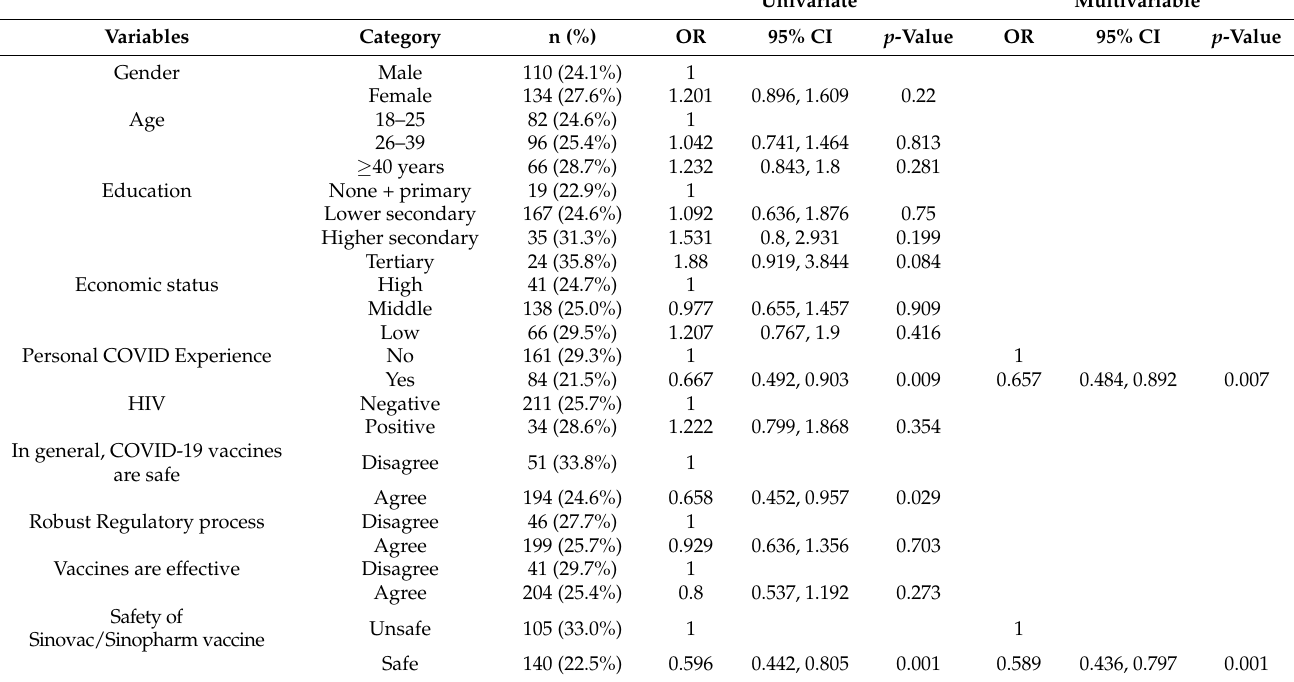
Table 5. Factors associated with having at least one side effect following the first vaccine